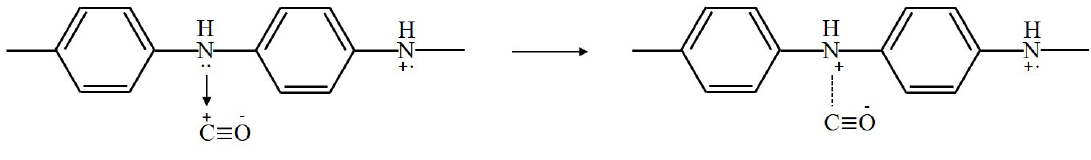
Figure 6. Sensing mechanism of PANi exposed to carbon monoxide.